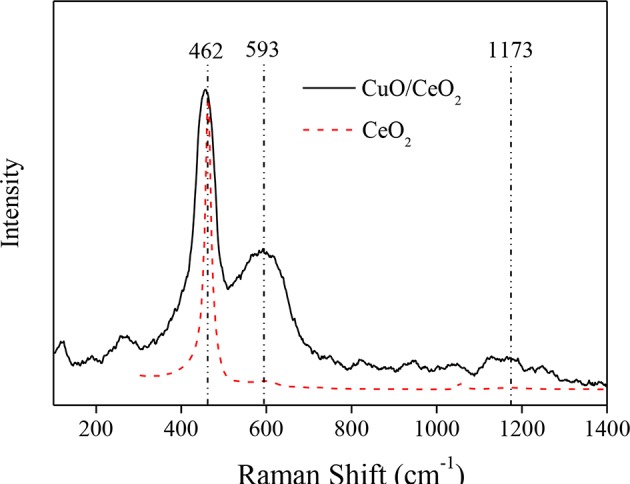
Raman spectra of CuO/CeO2 and CeO2.